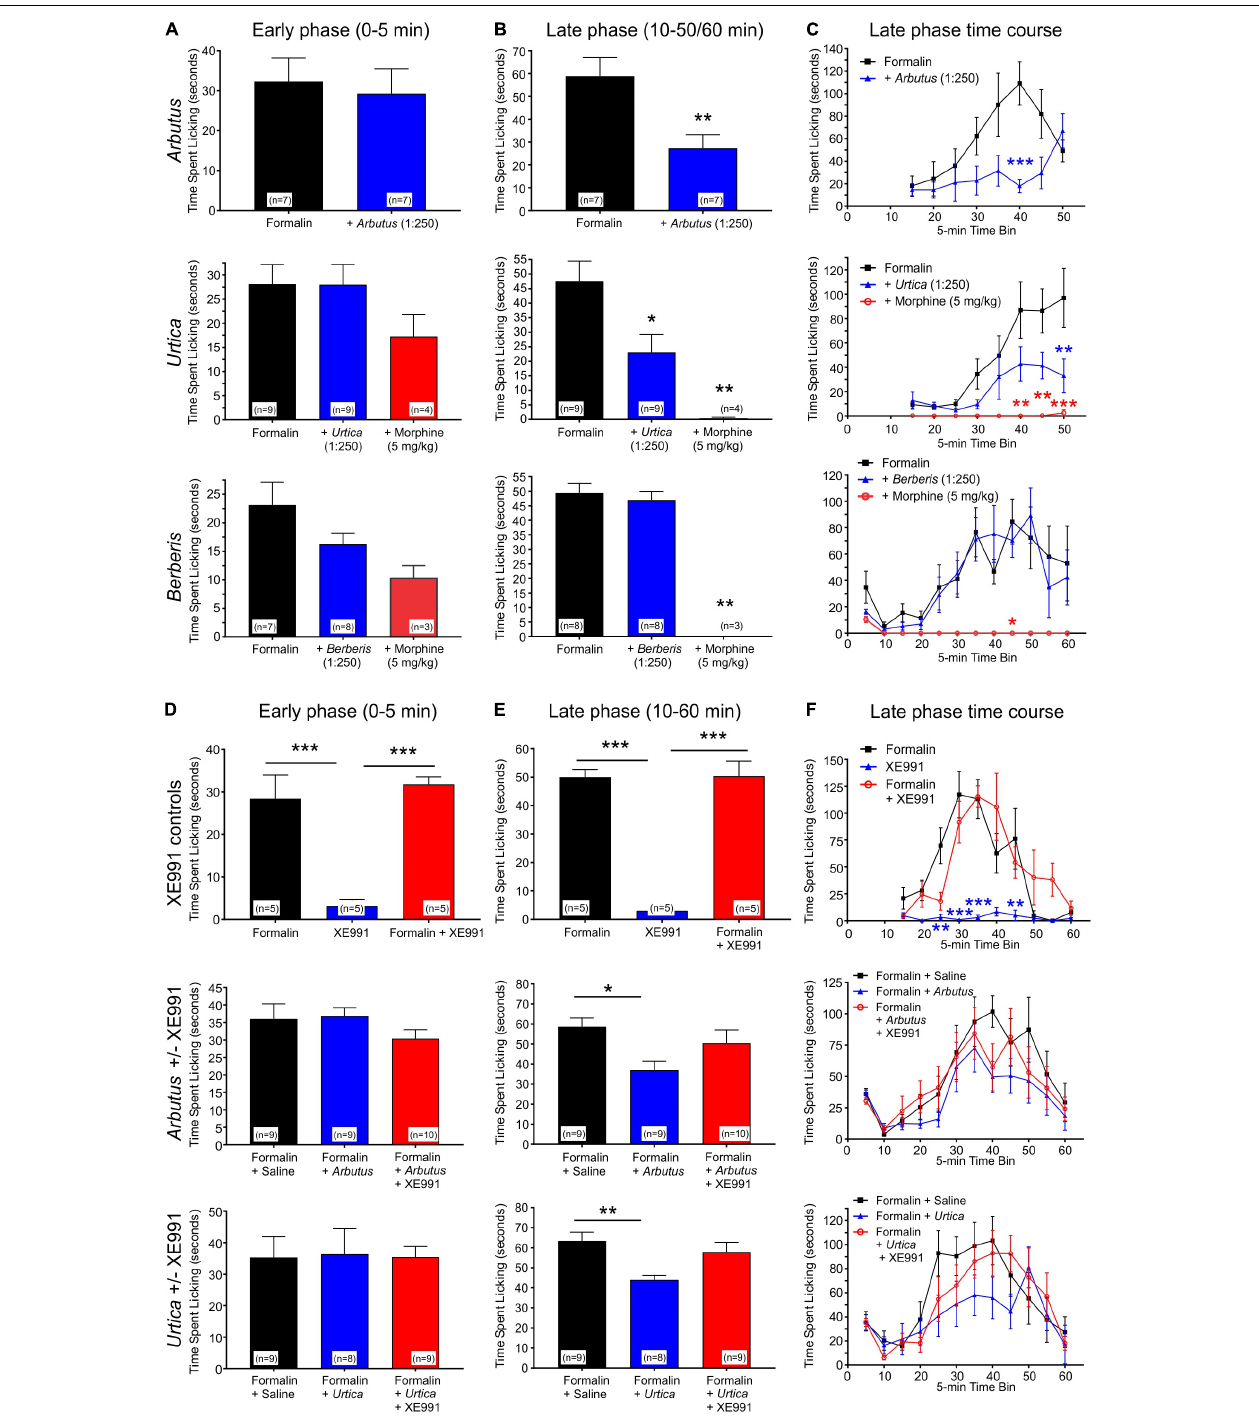
FIGURE 4 | Local administration of plant extracts in a mouse formalin paw lick model. All error bars indicate SEM. n = number of mice. Statistical analyses for all panels were by one-way ANOVA, except where indicated as two-way ANOVA. * p < 0 . 05; ** p < 0 . 01; *** p < 0 . 001. (A) Licking in the early (acute) phase of the formalin assay in the presence or absence of A. menziesii , U. dioica, B. nervosa , or morphine as indicated. (B) Average licking per 5-min time bin in the late (chronic) phase of the formalin assay. Arbutus ( p < 0.01, n = 7), Urtica ( p < 0.05, n = 9), and morphine ( p < 0.01, n = 3–4) each significantly reduced paw licking in the late phase, while there was no difference with Berberis ( p > 0.05, n = 8). (C) Time course by 5-min time bins for the formalin assay. In a two-way ANOVA comparing the late phase of formalin alone to formalin with plant extract, there was a significant main effect of treatment for Arbutus ( p = 0.0087) and Urtica ( p = 0.017), but not for Berberis ( p = 0.61). (D)